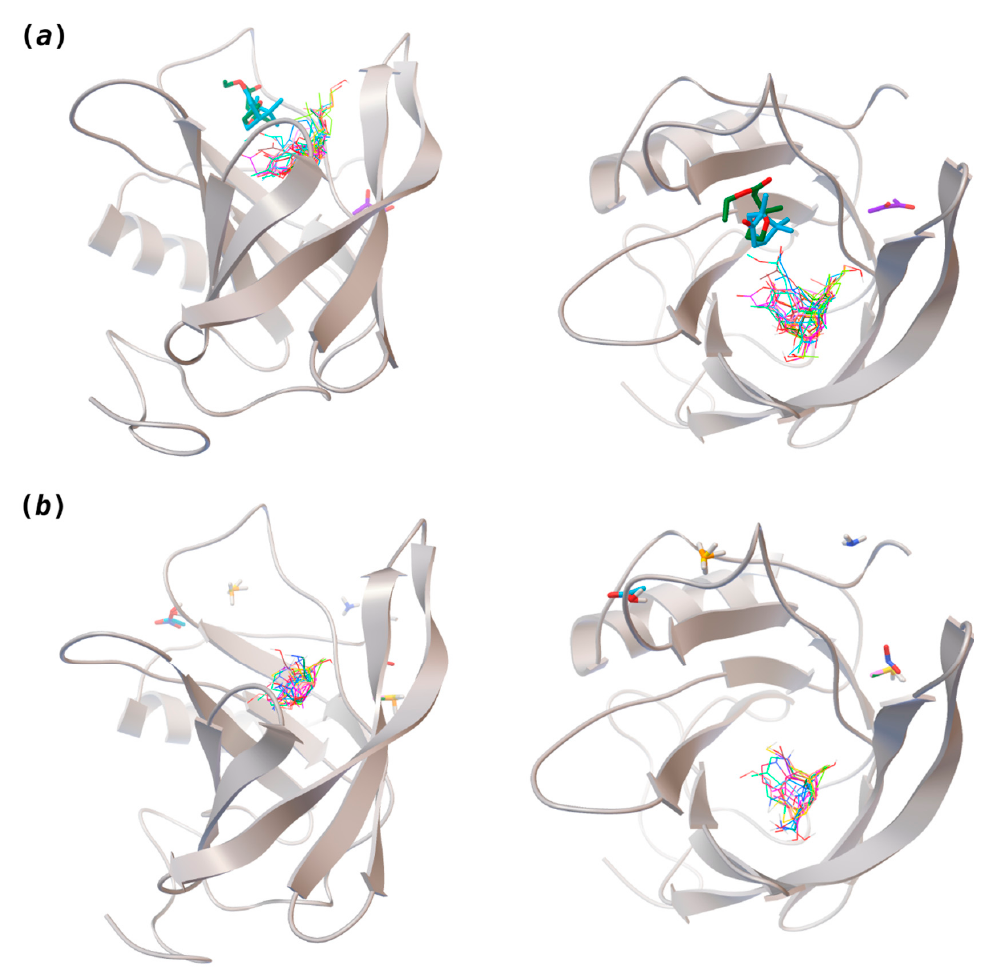
Figure 2. Interaction-binding modes of the selected ( a ) pleasant and ( b ) unpleasant odorant molecules, estimated with AutoDock Vina. Odorants in the most populated binding site are represented in diverse color lines, while odorants in other locations are shown in colored sticks. The human odorant-binding protein (hOBP) target is shown in the gray design. PC1 represents 69.60% and PC2 17.45%; thus, over 87% of data are described by the